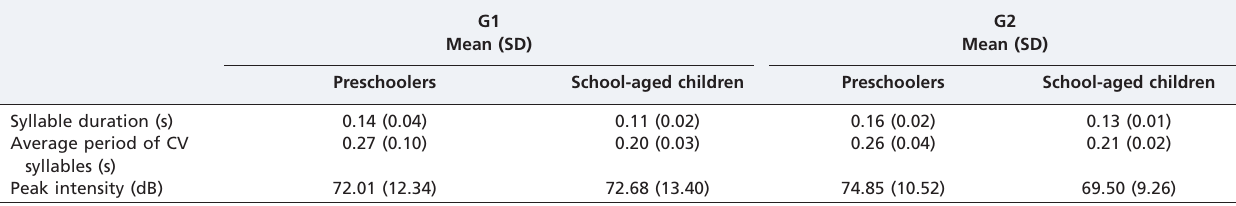
Table 2 - Mean (standard deviation) values of acoustic variables.